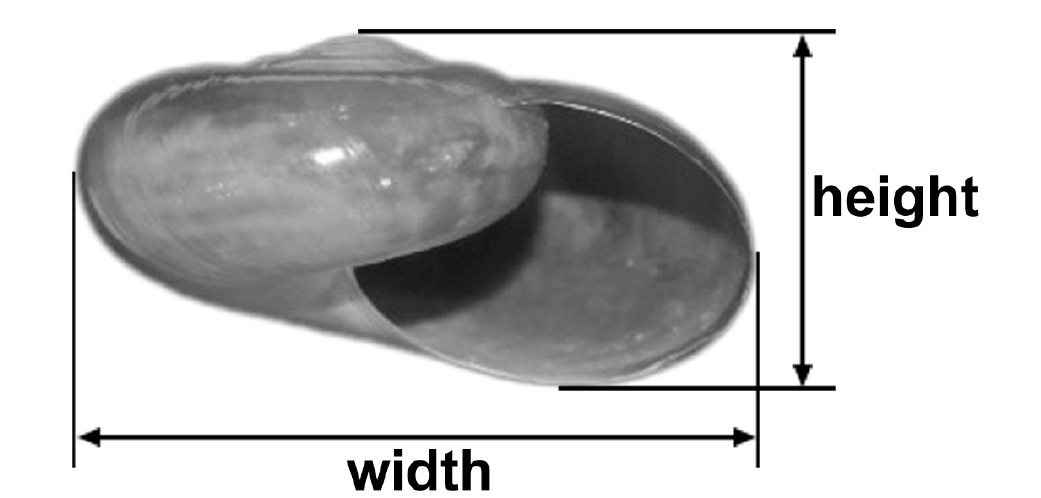
Fig. 2. Shell height and width, as measured for this study. The shell axis is parallel to the height and perpendicular to the